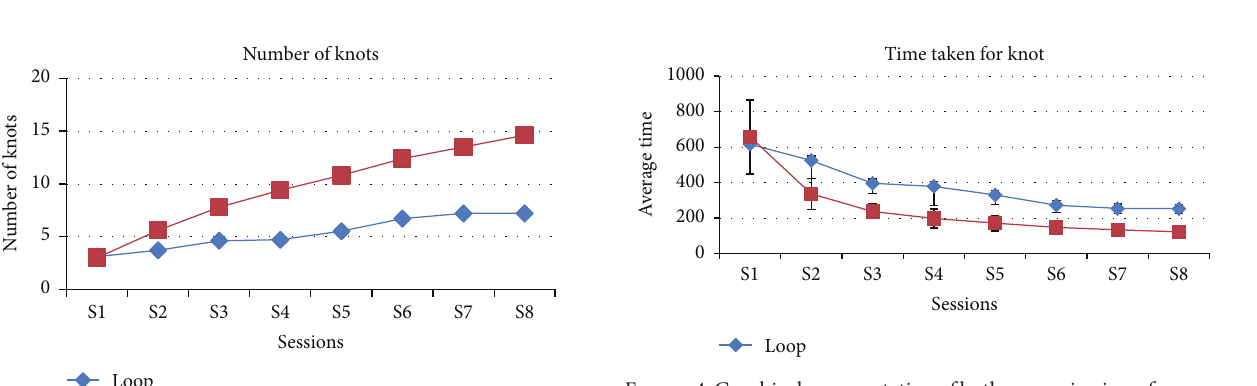
Figure4:Graphicalrepresentationofbothgroupsinviewofaverage time in seconds for single set of knots in each